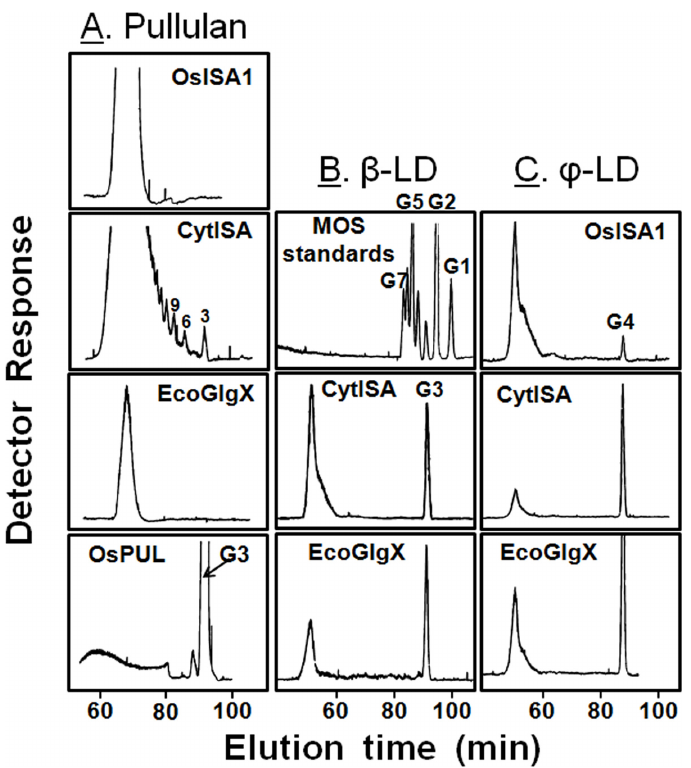
Fig 11. Amounts of MOSs liberated after treatment of pullulan, β -limit dextrins, and Φ -limit dextrins with DBEs. The liberated MOSs liberated after DBE enzymatic reactions with pullulan (A), β -LD (B) or Φ -LD (C) were separated by HPLC gel filtration chromatography and detected by an Evaporating Light Scattering Detector. Sugars or MOS standards: glucose (G1); maltose (G2); maltotriose (G3); maltotetraose (G4); maltopentaose (G5); maltohexaose (G6), and so on.